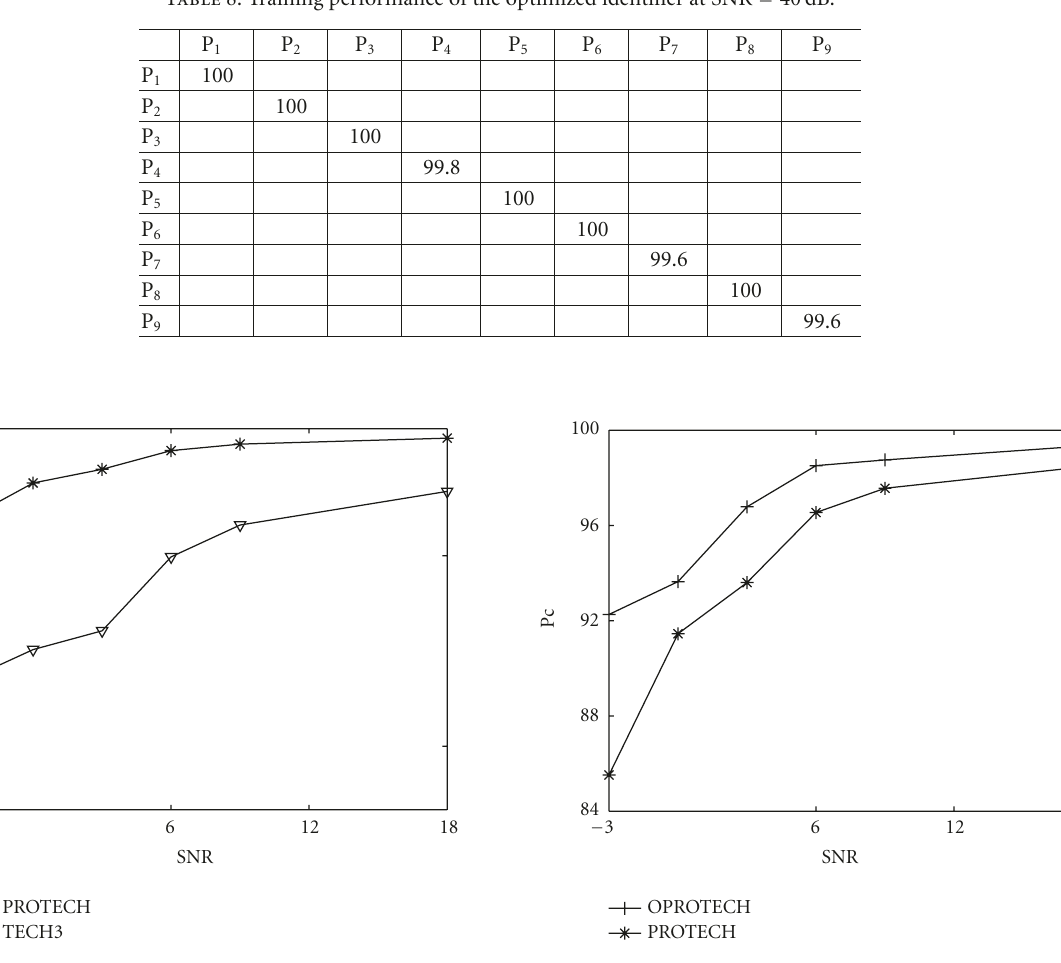
Table 8: Training performance of the optimized identifier at SNR = 40 dB.